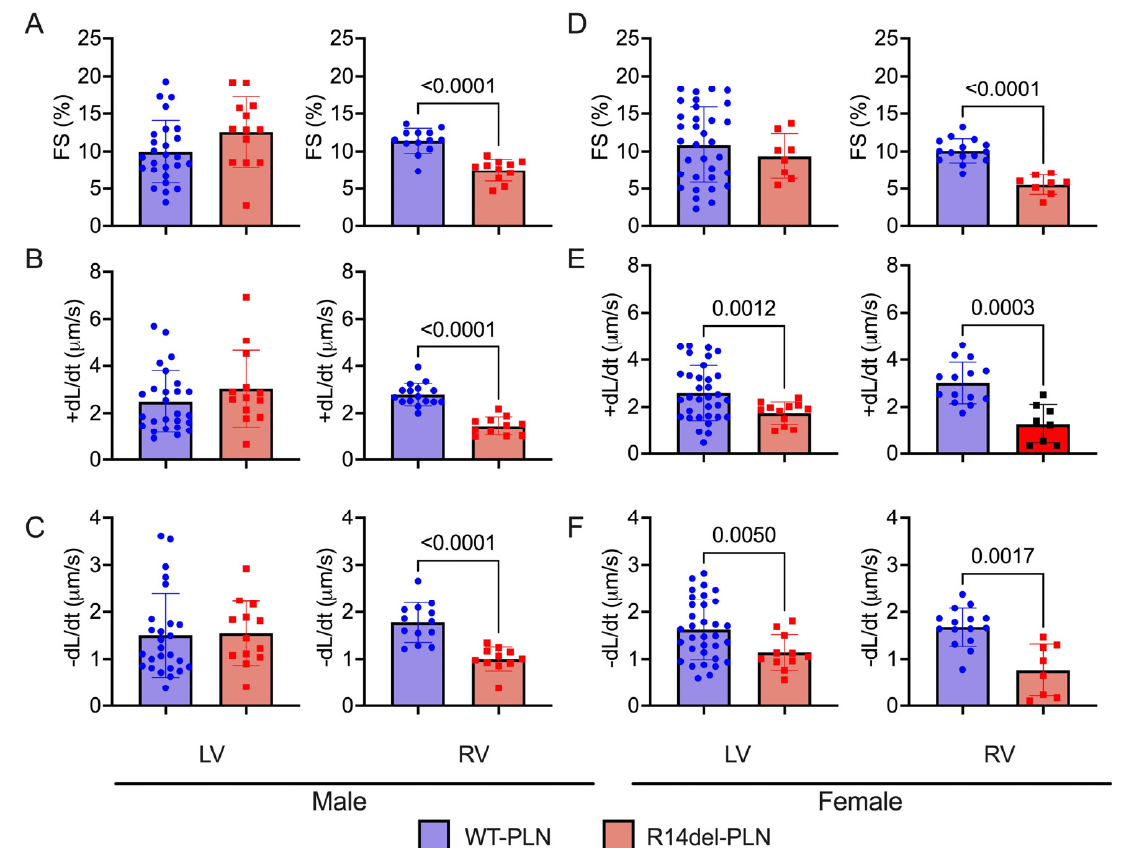
Figure 4. Contractile parameters in isolated cardiomyocytes from 12-month-old male (left panels) and female (right panels) WT- PLN and R14del- PLN mice. ( A , D ) Fractional shortening (FS) in % at 0.5 Hz. ( B , E ) Maximum rates of contraction velocity (+dL/dt). ( C , F ) Maximum rates of relaxation velocity ( − dL/dt). n = 23 LV and 15 RV cells for WT males (N = 3 hearts); n = 37 LV and 12 RV cells for WT females (N = 5 hearts). n = 13 LV and 11 RV cells for R14del- PLN males (N = 3 hearts); n = 8 LV and 8 RV cells for R14del- PLN females (N = 3 hearts). Data are expressed as mean ± SD for the number of cells, and statistical analyses were performed with Student’s unpaired t -test.